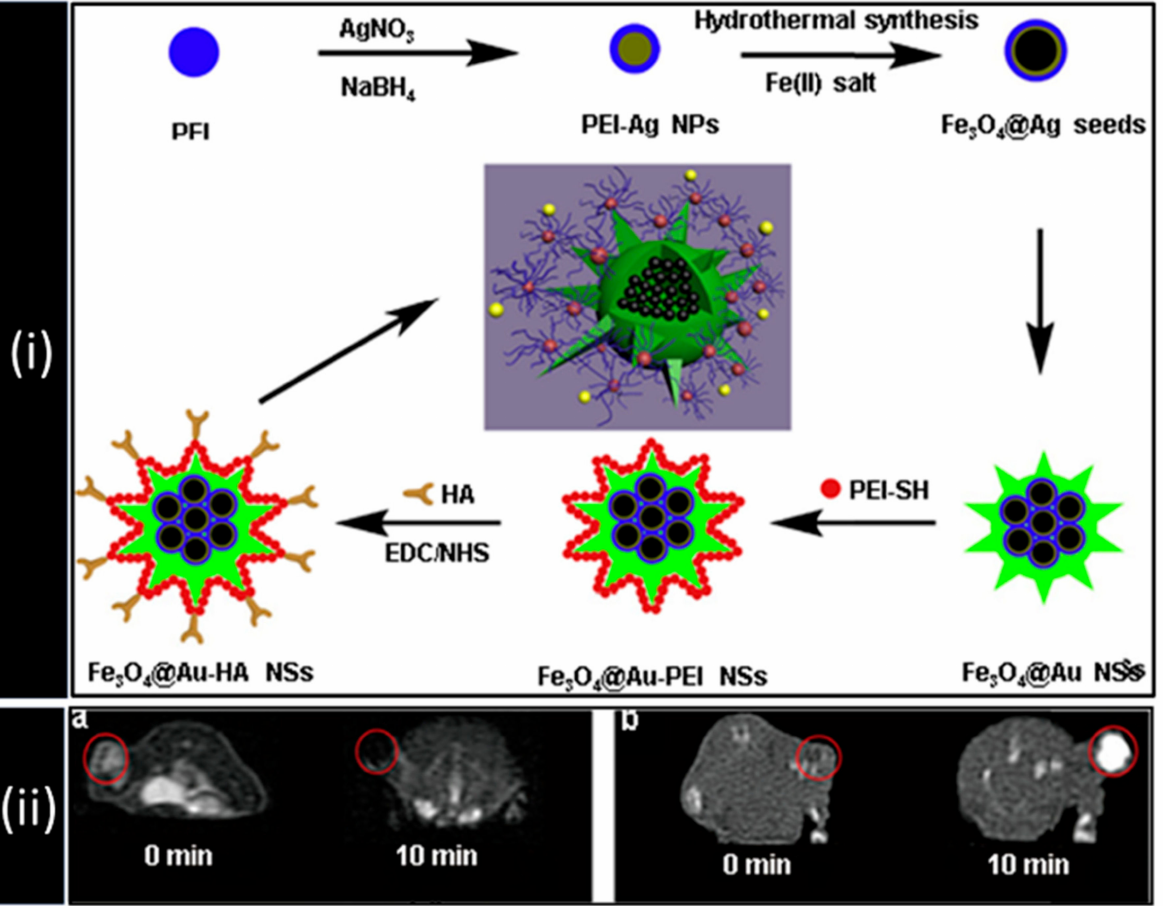
Figure 7. ( i ): Schematic illustration of the synthesis of Fe 3 O 4 @Au- hyaluronic acid (HA) nanostars (NSs). ( ii ): ( a ) T 2 - weighted MRI scan and ( b ) CT images of the tumors in a xenografted tumor model before injection and 10 min post intratumoral injection of nanocomposites. Red circles in Figure 7ii represent selected tumor sites. Reprinted with permission from ref. [69]. Copyright 2015